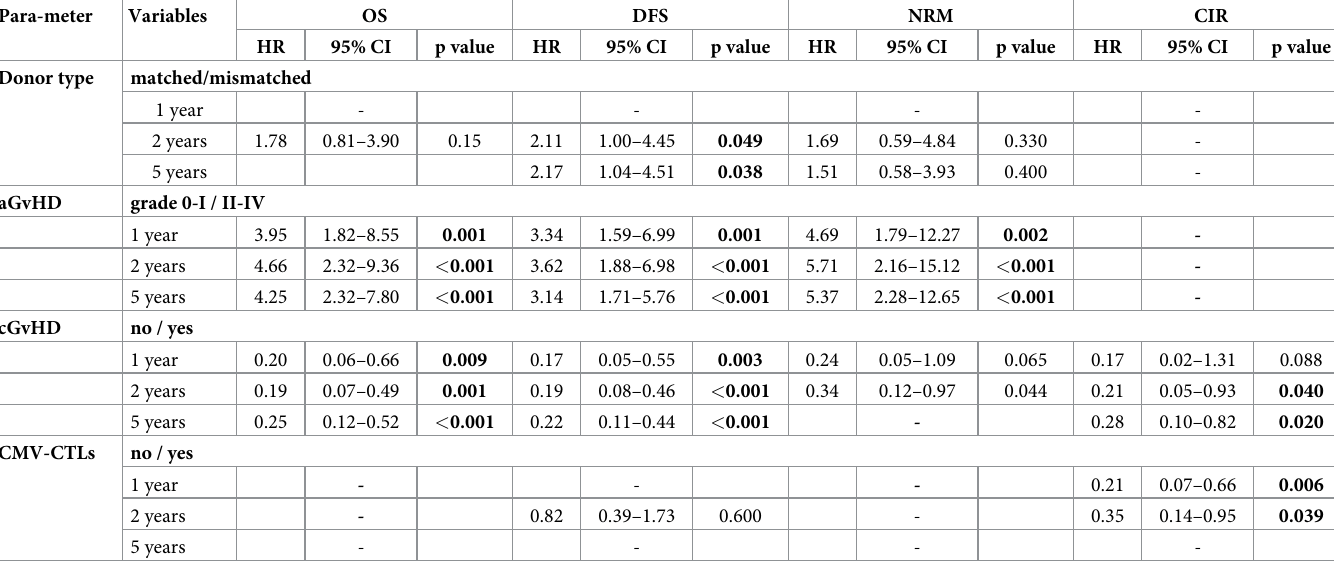
Multivariable regression analysis of the outcome was performed only with those parameters statistically significant in the univariate analysis at 1, 2 or 5 years after allo- SCT. Multivariable regression analysis of OS and DFS were performed by Cox-regression/cox proportional hazard regression analysis. Analysis of NRM and CIR were performed by the Fine and Gray test. The second column shows for each tested parameter two alternative variables. Not significant data sets are indicated by”-”in the 95% CI column. For the calculation of the hazard ratio, the first variable was set as